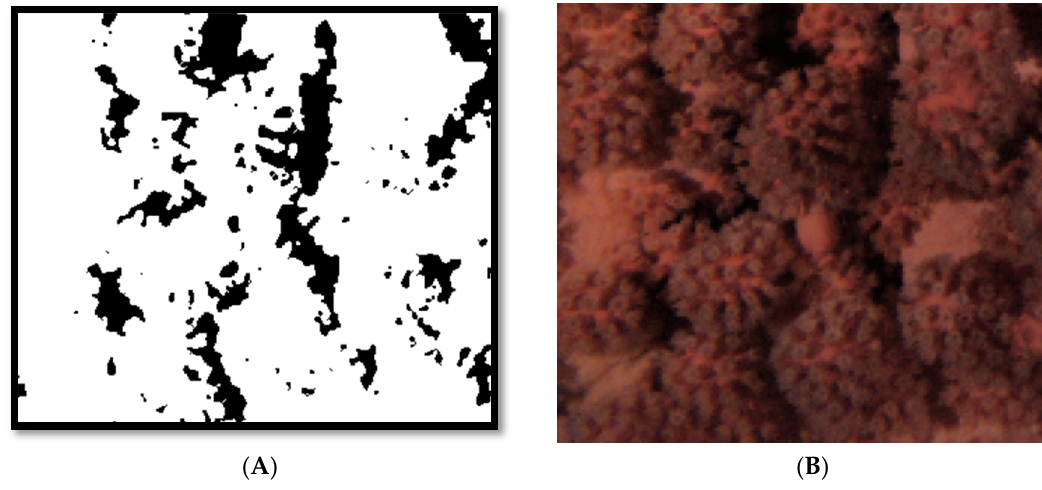
Figure 6. Output of coral section segmentation ( A ) and binarization with median filter ( B ).